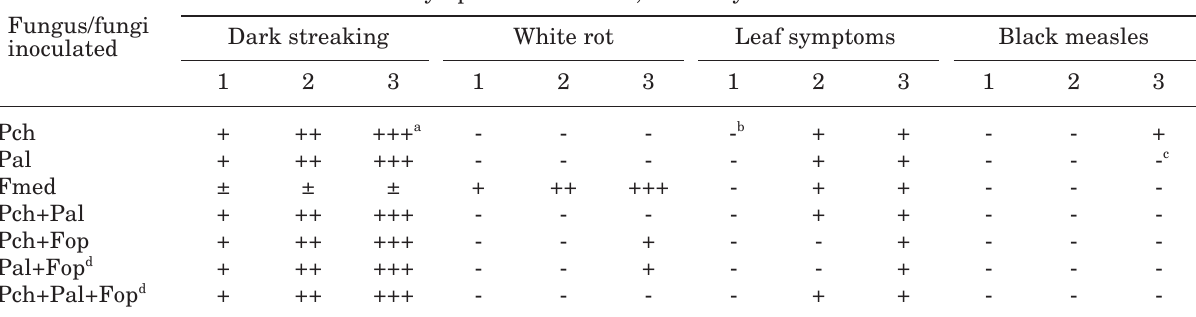
Table 3. Outcome of inoculations of two grapevine cultivars (Matilde and Italia, 9- and 5-year-old respectively) with P. chlamydospora (Pch), P. aleophilum (Pal) and F. punctata ( =F. mediterranea ) (Fop), alone and in all possible combinations (from Sparapano et al. ,